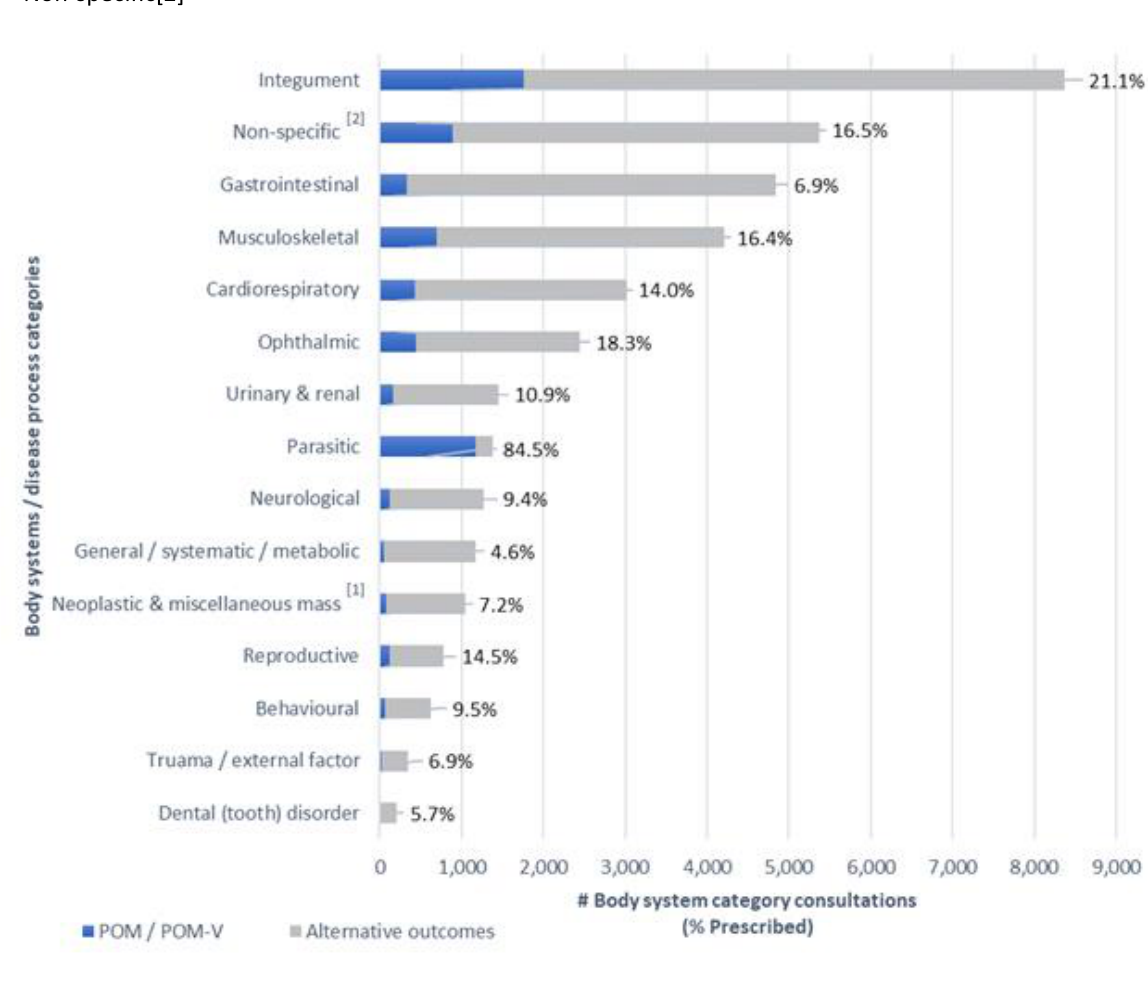
Figure 5: Remote consultations with and without POM-V / POM prescriptions, grouped into body system / disease